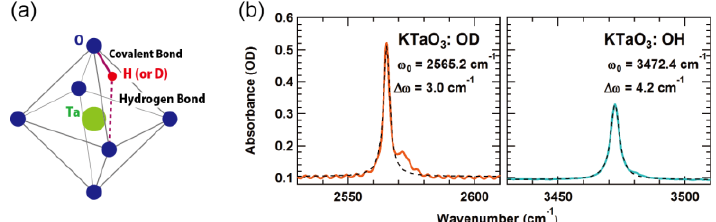
Fig. 1. (a) The crystal structure of KTaO 3 . Potassium atoms are not shown. (b) IR absorption spectra for OD (left) and OH (right) modes. Black dashed curves are the fittings with a Lorentzian